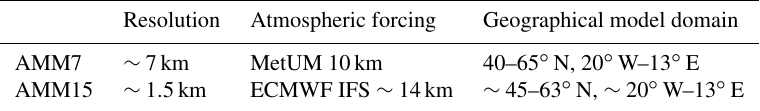
Table 2. Details of equivalent neighbourhoods used when comparing AMM7 and AMM15. AMM7 AMM15 Name Total points Shape Size (E–W) Total